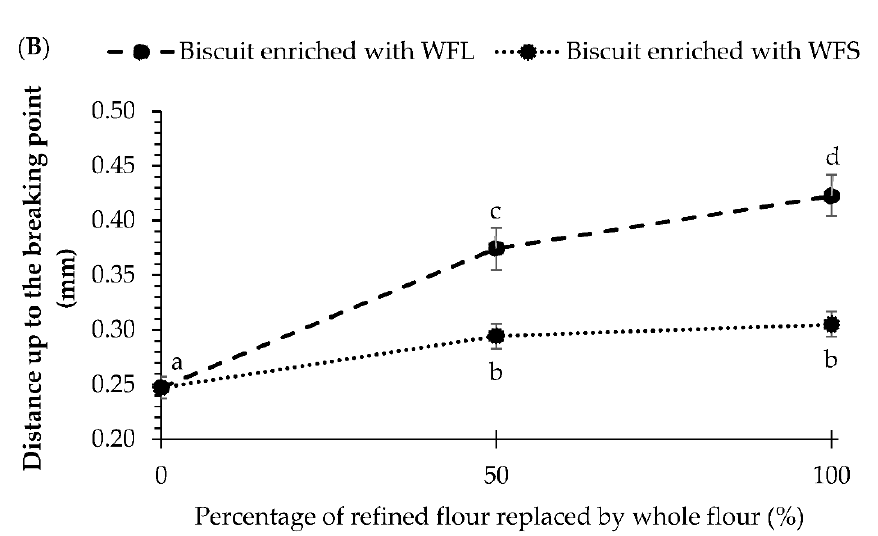
Figure 6. Maximum breaking force ( A ) and fracturability ( B ) of biscuits prepared with refined flour and enriched with whole flours containing coarse or fine bran (WFL or WFS) at 50 or 100% of replacement, respectively. Data are observed mean ± confidence intervals at 95%. Different scripts per parameter denote significant differences ( p < 0.05).